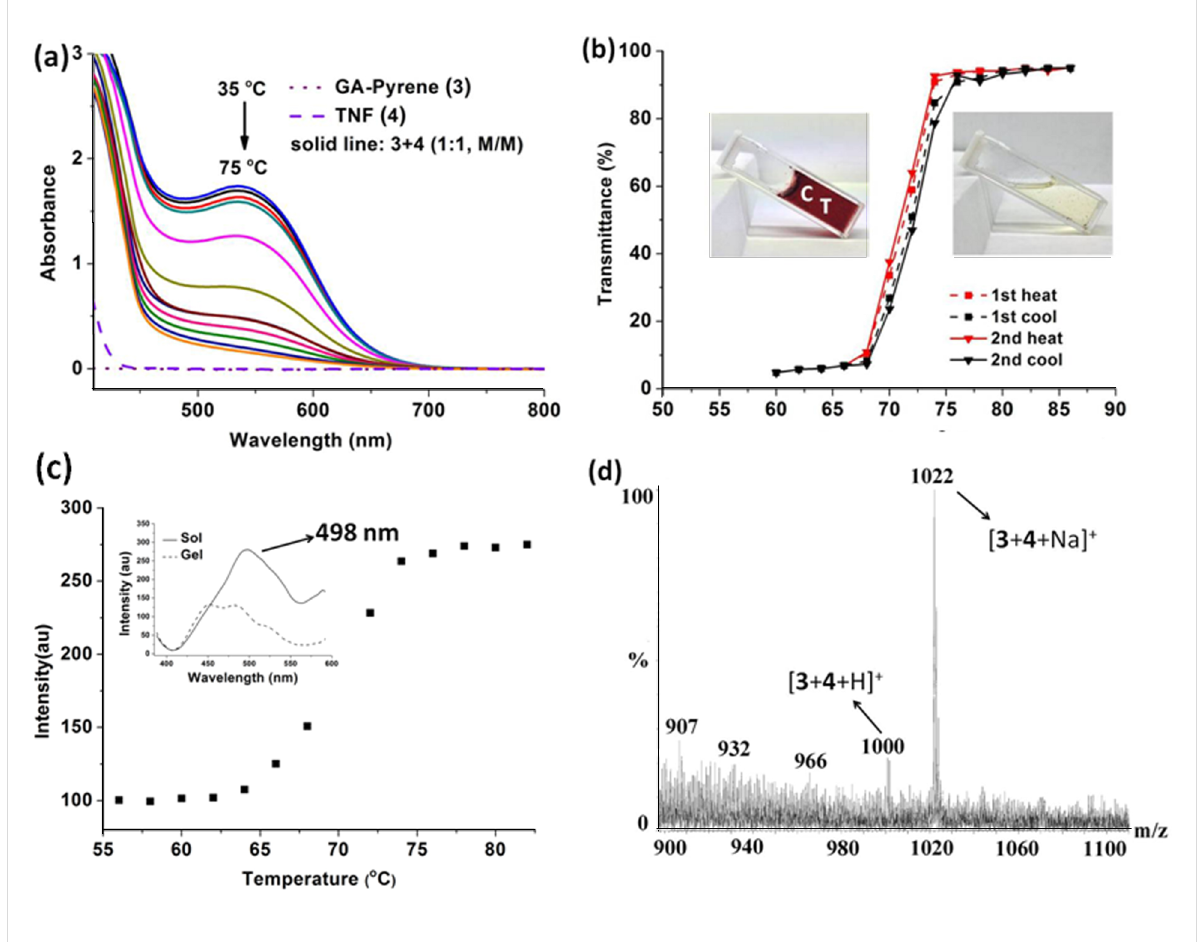
Figure 7: (a) UV–vis, (b) transmittance at 700 nm, (c) fluorescence intensity at 498 nm (excitation: 365 nm) at various temperatures of CT gel ( 3 / 4 = 1:1, molar ratio) in DMSO/water (3:1, v/v), inset: fluorescence spectra of gel and sol, [ 3 ] = 12 mM], and (d) ESIMS (+) of 3 and 4 (1:1, molar ratio) in